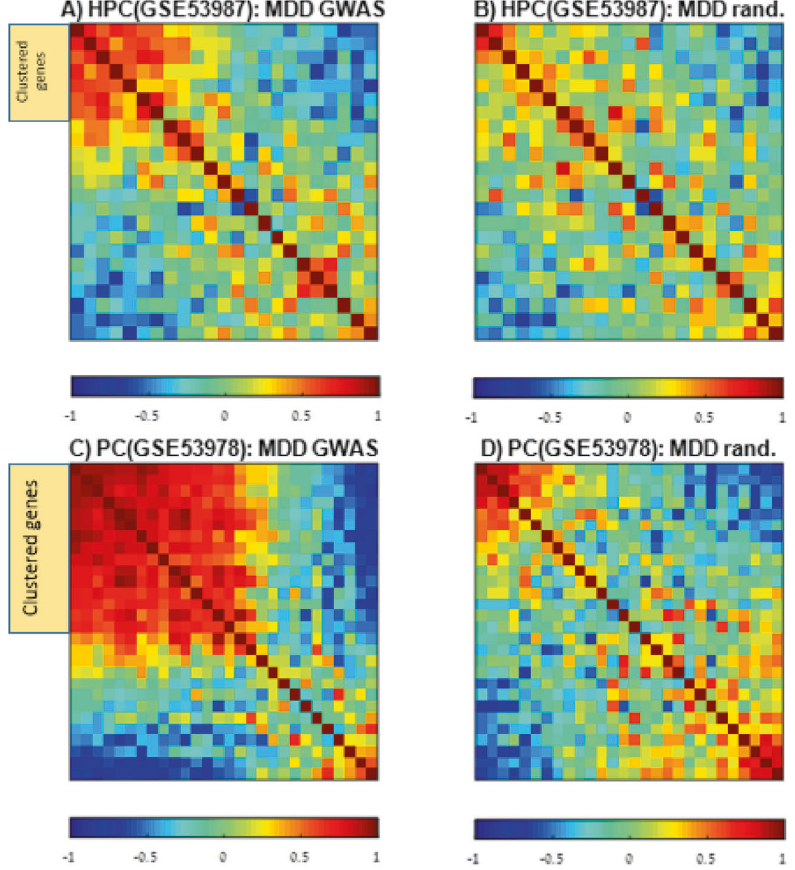
Fig. 1 Correlation expression matrix of the GWAS-derived genes. The color in each entry ( x , y ) represents the correlation between the expression of genes x and y , along with all MDD samples in the speci fi ed brain region. Red color indicates high-correlated expression and blue, low. We used the SPIN tool [40]) to sort the list of genes so that genes with similar expression patterns would be grouped together. A The Pearson correlation expression matrix of the 23 GWAS-derived genes was calculated along with hippocampal (HPC) samples of MDD patients (GSE53987 data). Note that 23 of the 37 GWAS-derived genes were present in GSE53987. The orange rectangle represents the cluster of genes with highly correlated expression. B The Pearson correlation expression matrix of 23 randomly selected genes was calculated along with HPC samples of persons with MDD (GSE53987 data). C The Pearson correlation expression matrix of the 28 GWAS-derived genes calculated along parietal cortex (PC) samples of MDD patients (GSE53978 data). Note that 28 of the 37 GWAS-derived genes were present in GSE53978. The orange rectangle represents the cluster of genes with highly correlated expression. D The Pearson correlation expression matrix of 28 randomly selected genes was calculated along with PC samples of persons with MDD (GSE53978